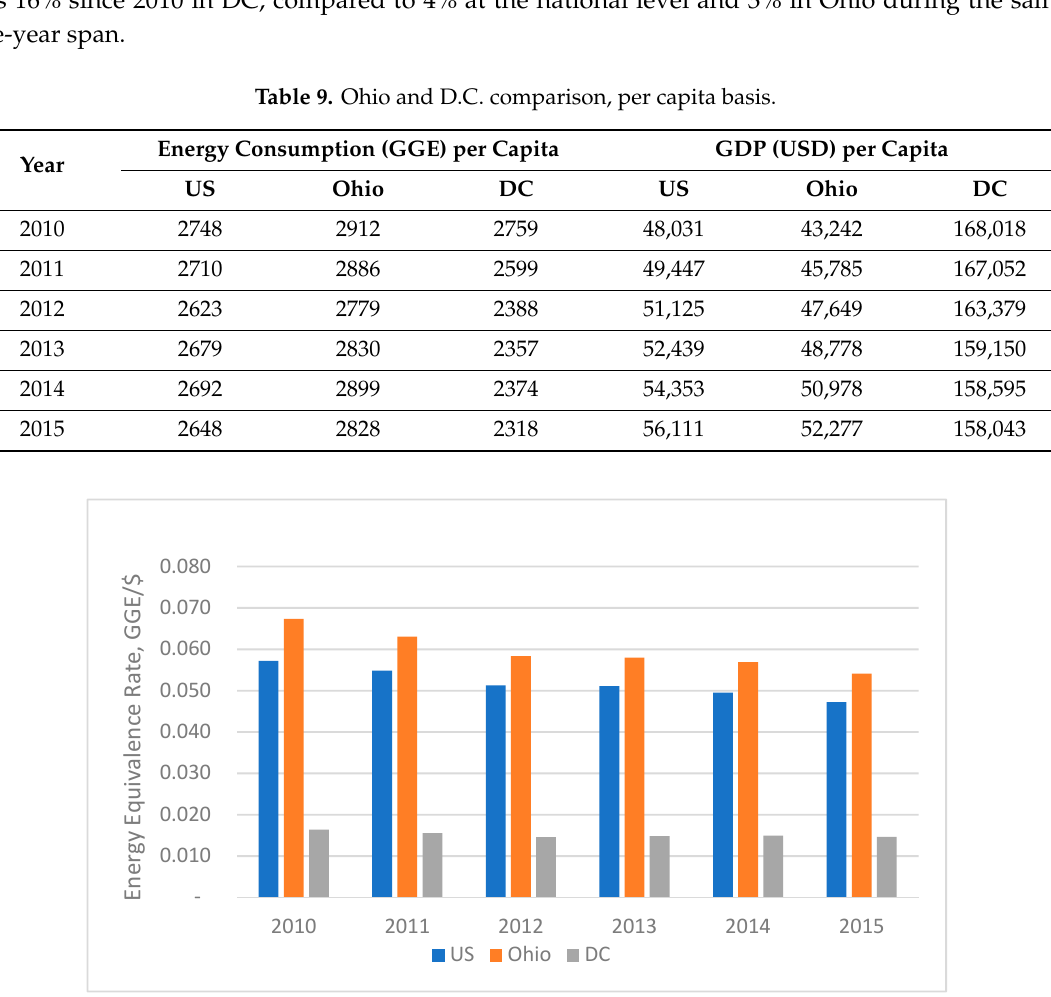
Figure 9. Comparison of energy equivalence rate for the United States, Ohio, and Washington, D.C. Table 9. Ohio and D.C. comparison, per capita basis.